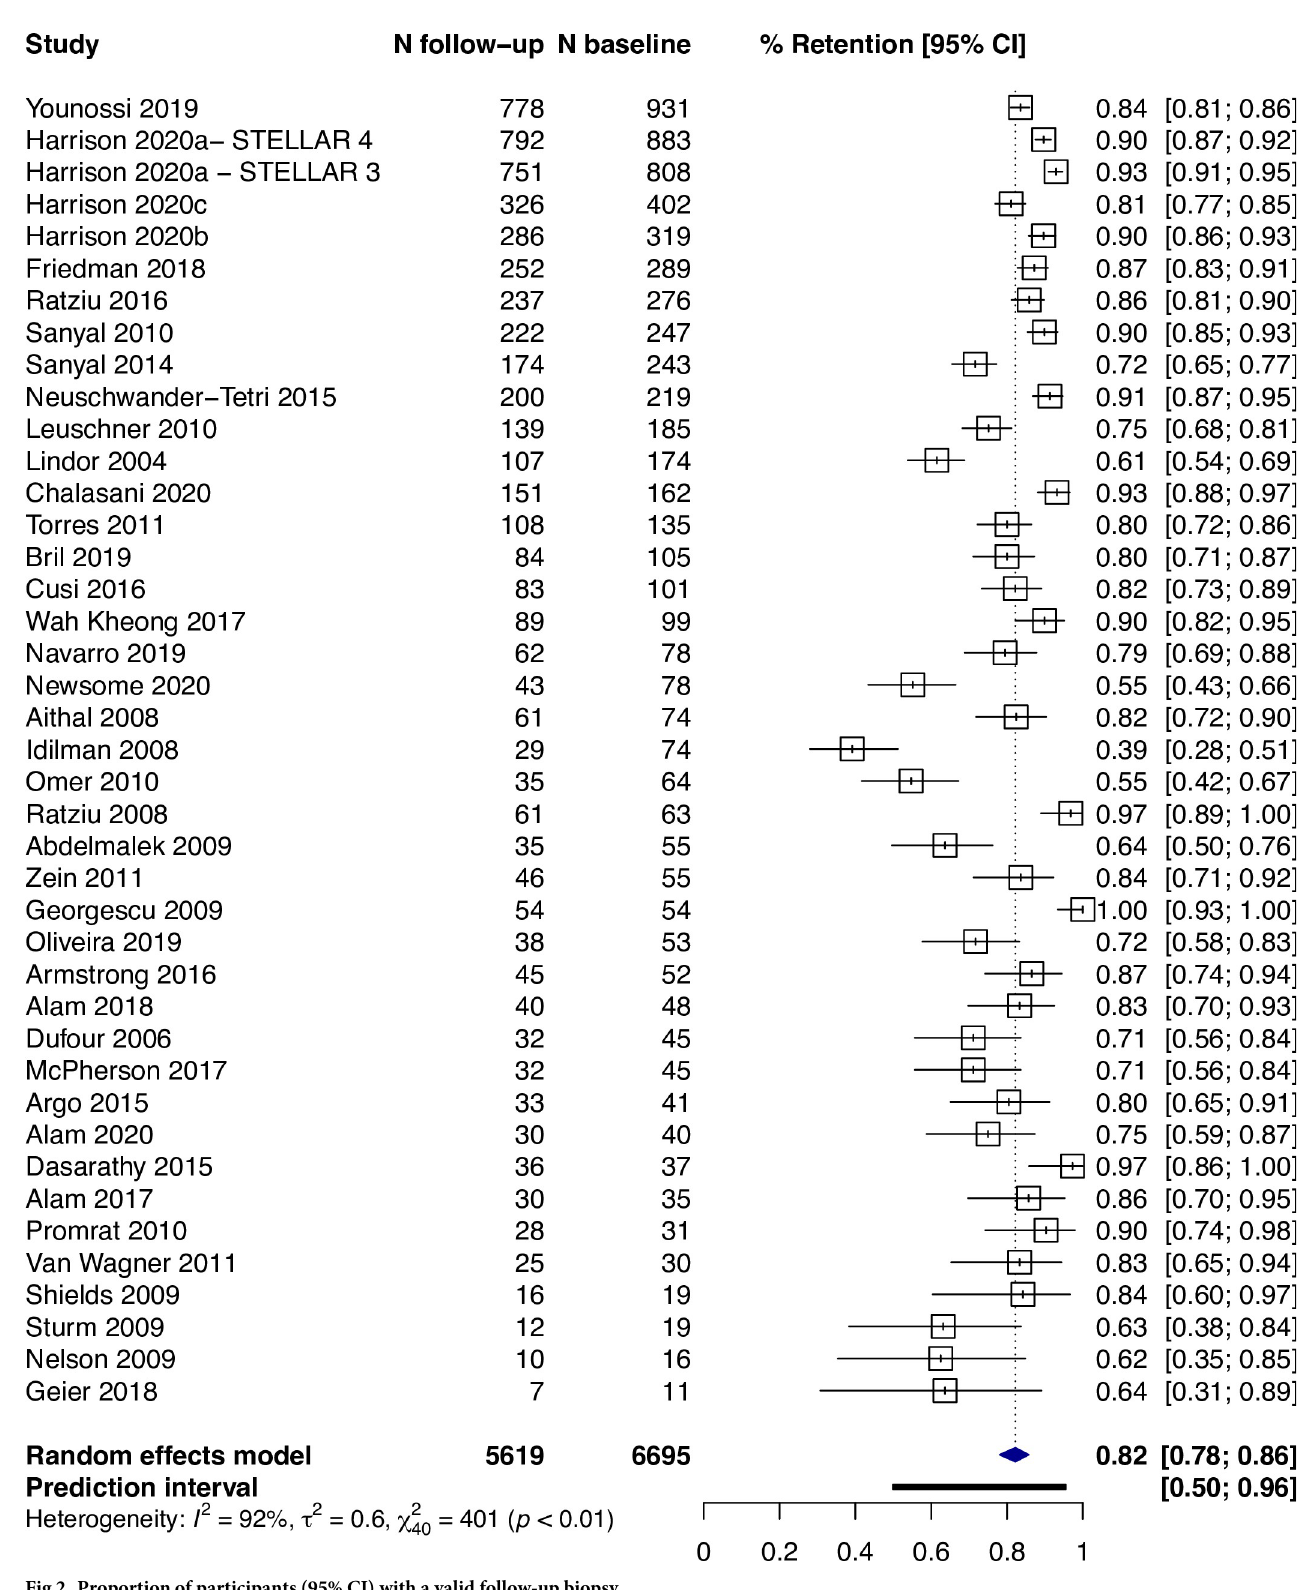
PLOS ONE | https://doi.org/10.1371/journal.pone.0250385 April 21,